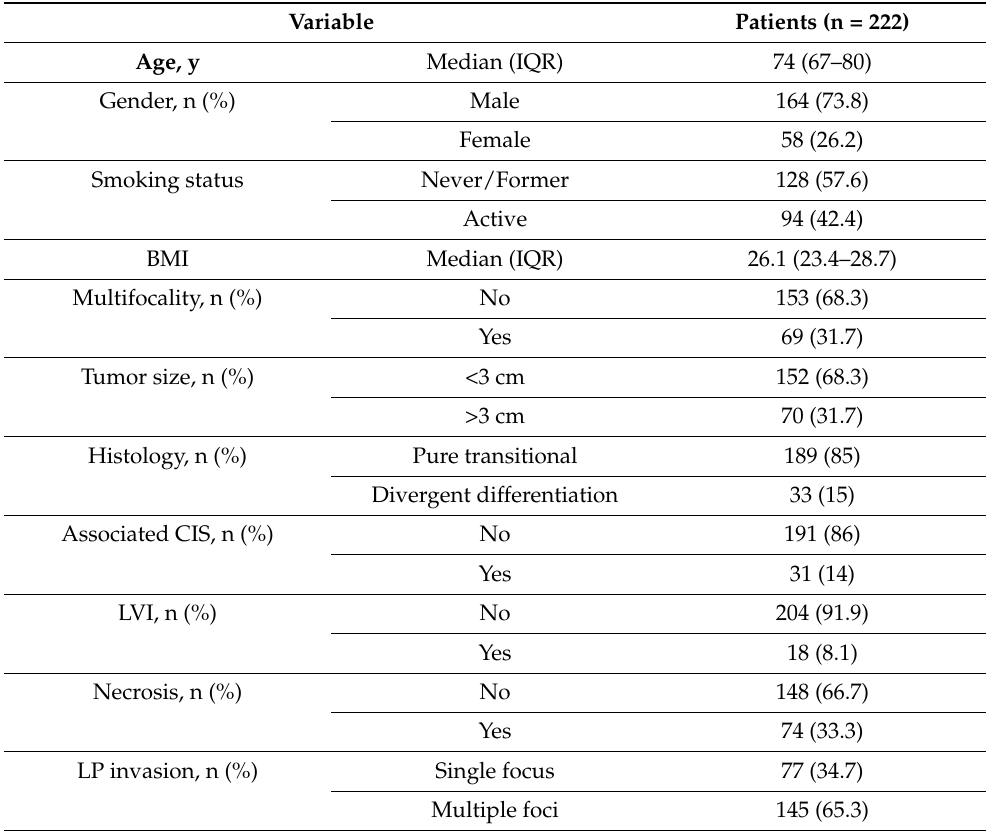
Table 1. Patients’ clinico-pathologic